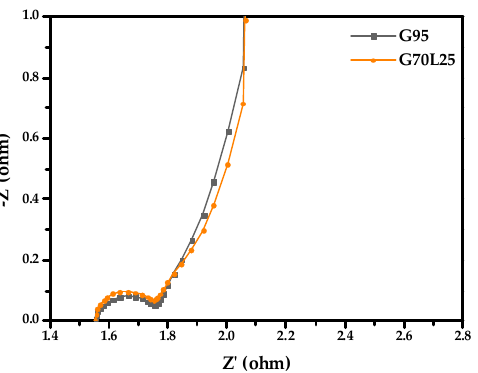
Figure 8. Impedance spectra of the G95 and G70L25 electrodes, measured at an AC amplitude of 10 mV, in H 2 SO 4 electrolyte.